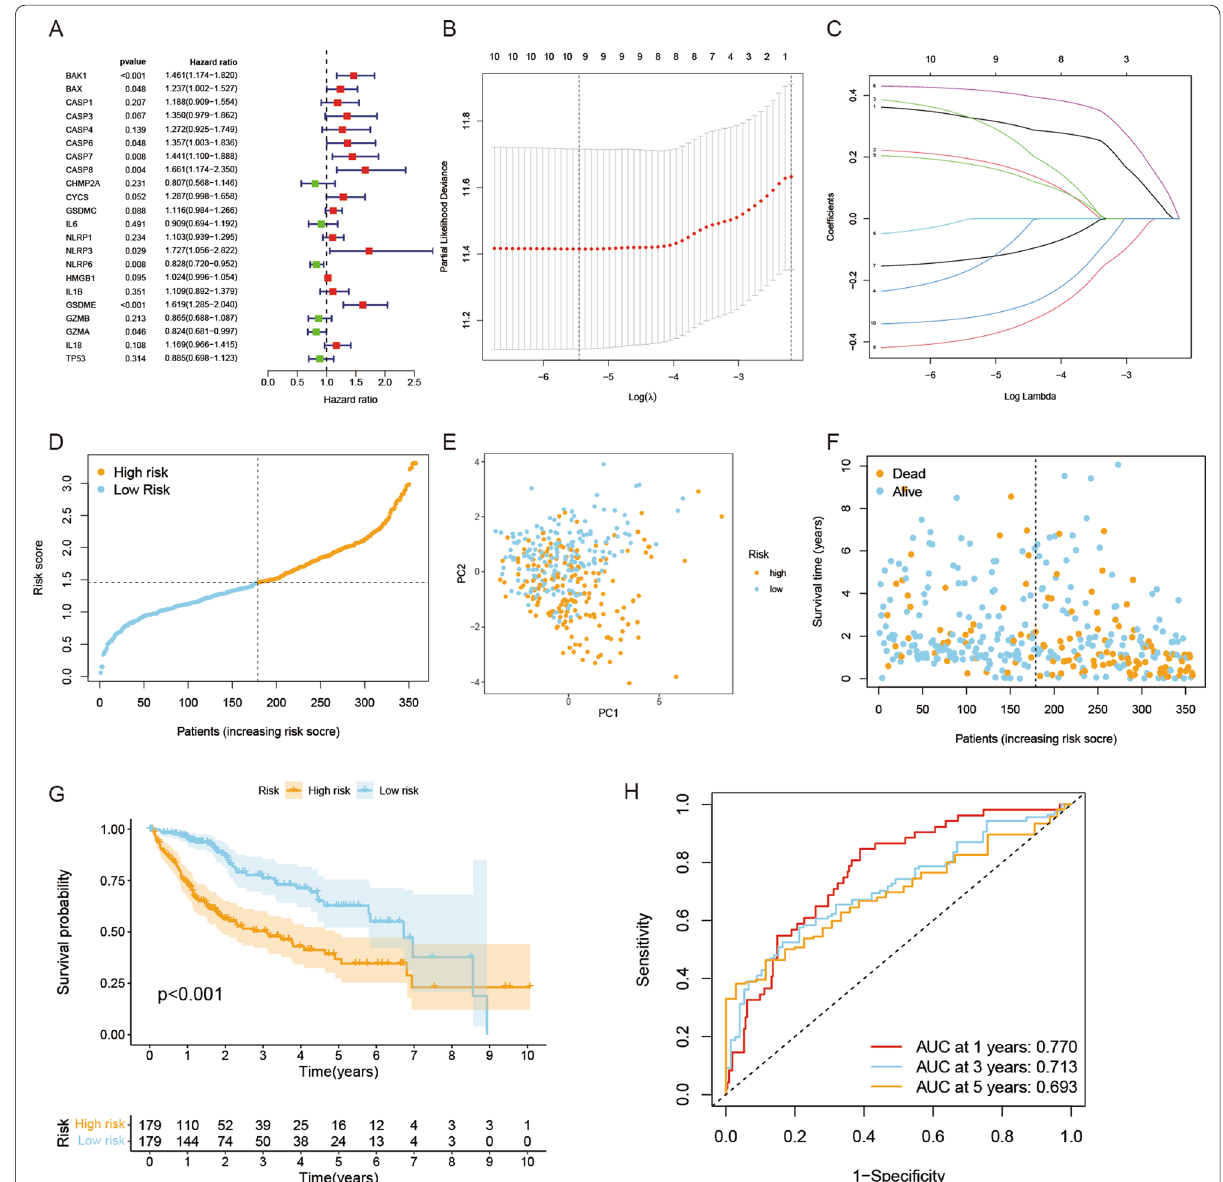
Fig. 3 Construction of the risk signature in the TCGA cohort. A Univariate Cox regression analysis of HCC for each PRG and 10 genes with P < 0.2. B Cross-validation for tuning the parameter selection in the LASSO regression. C LASSO regression of the 10 OS-related genes. D Distribution of patients based on the risk score. E PCA plot for HCCs based on the risk score. F The survival status for each patient (low-risk population: on the left side of the dotted line; high-risk population: on the right side of the dotted line). G Kaplan–Meier curves for the OS of patients in the high- and low-risk groups. H ROC curves demonstrated the predictive efficiency of the risk